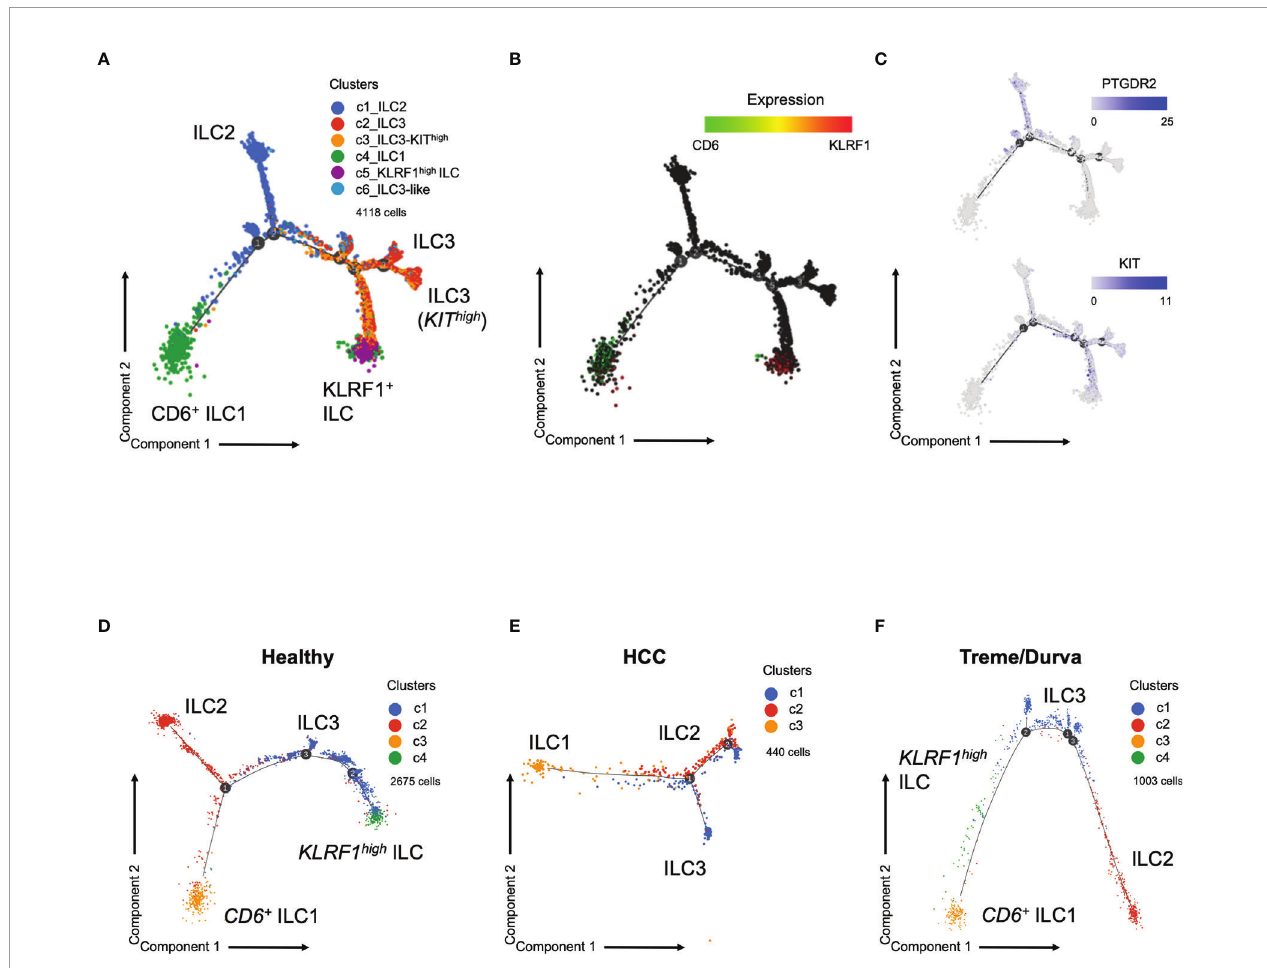
FIGURE 4 | (A) Trajectory plot of cells analyzed by scRNA-seq. Same groups and clusters as in Figure 2A . (B) Expression of ILC marker CD6 and KLRF1 in cells on trajectory plot. (C) Expression of ILC markers PTGDR2 and KIT in cells on the trajectory plot. D-F) Trajectory plot of cells analyzed by scRNA-seq now showing trajectories split by group. Graph-based clustering and UMAP plot presented in Figure S2 . (D) Trajectory plot of cells from healthy donors (three samples). (E) Trajectory plot of cell from HCC patients at baseline (three samples). (F) Trajectory plot of HCC patient during immunotherapy with tremelimumab and durvalumab (ICI, three